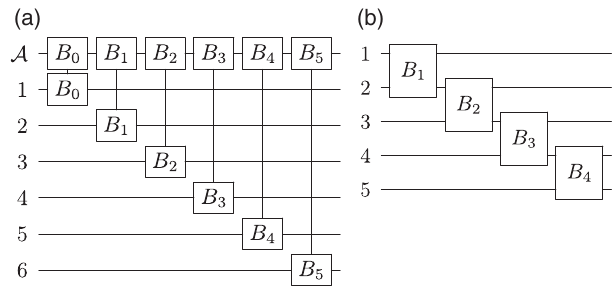
FIG. 2. (a) Optical circuit of a pass through the single loop, for input modes 1 – 6, loop mode A , and beam splitter operations B (b) Effective circuit for input modes 1 – 5 where modes A and 6 are initially vacuum and B 0 and B 5 are fully